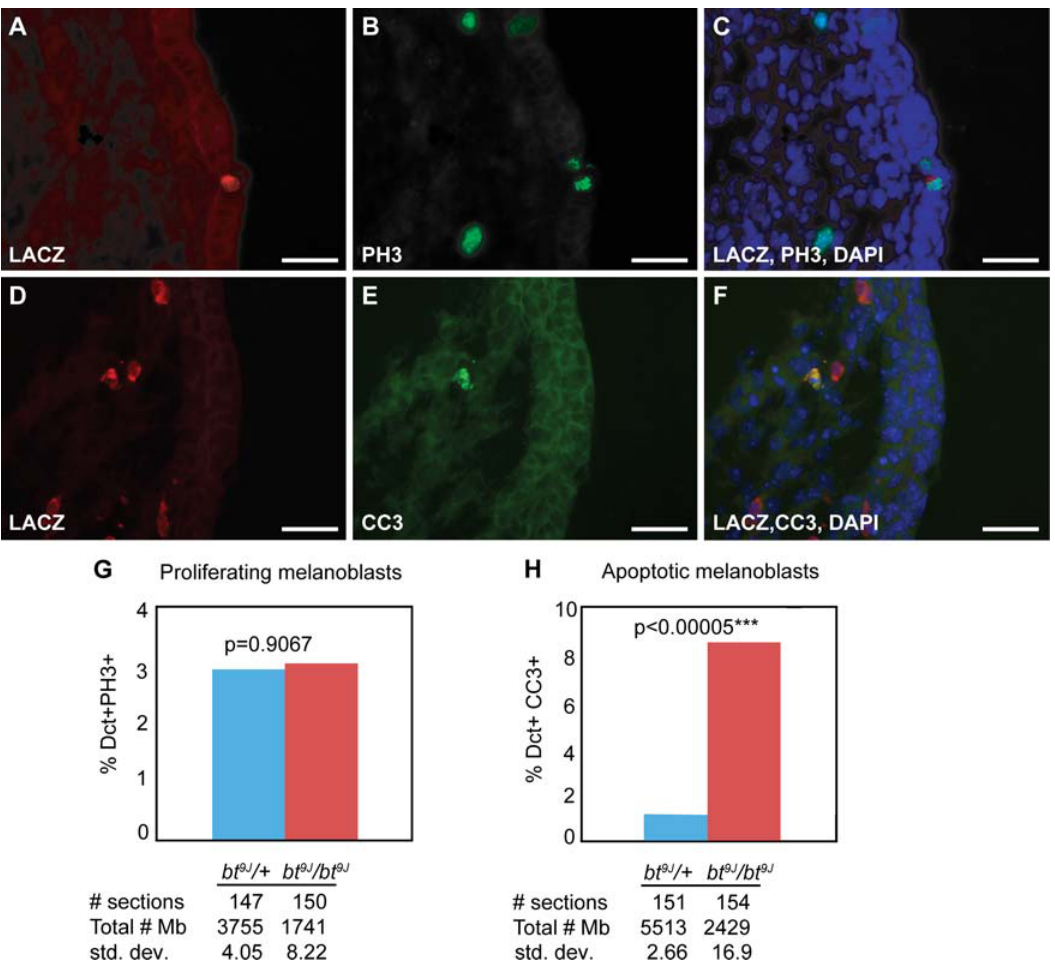
Figure 4. Melanoblast proliferation and apoptosis in bt 9J / + and bt 9J /bt 9J embryos. (A–F) Representative immunofluorescence images depicting 16 m m trunk sections from bt 9J /bt 9J E13.5 embryos assayed for proliferation (A–C) and apoptosis (D–F). Proliferating melanoblasts were identified by staining sections for LacZ (cytoplasmic red, A) and PH3 (nuclear green, B), and their co-localization together with nuclear DAPI staining (blue, C). Apoptotic melanoblasts were identified by staining sections for LacZ (cytoplasmic red, D) and CC3 (cytoplasmic green, E), and their co- localization together with DAPI (blue, F). (G–H) The Y axis (%Dct + PH3 + and %Dct + CC3) indicates the average percentage of total melanoblasts per section that are PH3 positive (G) or CC3 positive (H), for bt 9J / + (blue) and bt 9J /bt 9J (red) E13.5 embryos (n=5 embryos for each genotype). The total number of sections and melanoblasts analyzed are listed beneath each graph, as well as the standard deviations. Asterisks indicate highly significant P values. The scale bars are: (A–F) 50 m